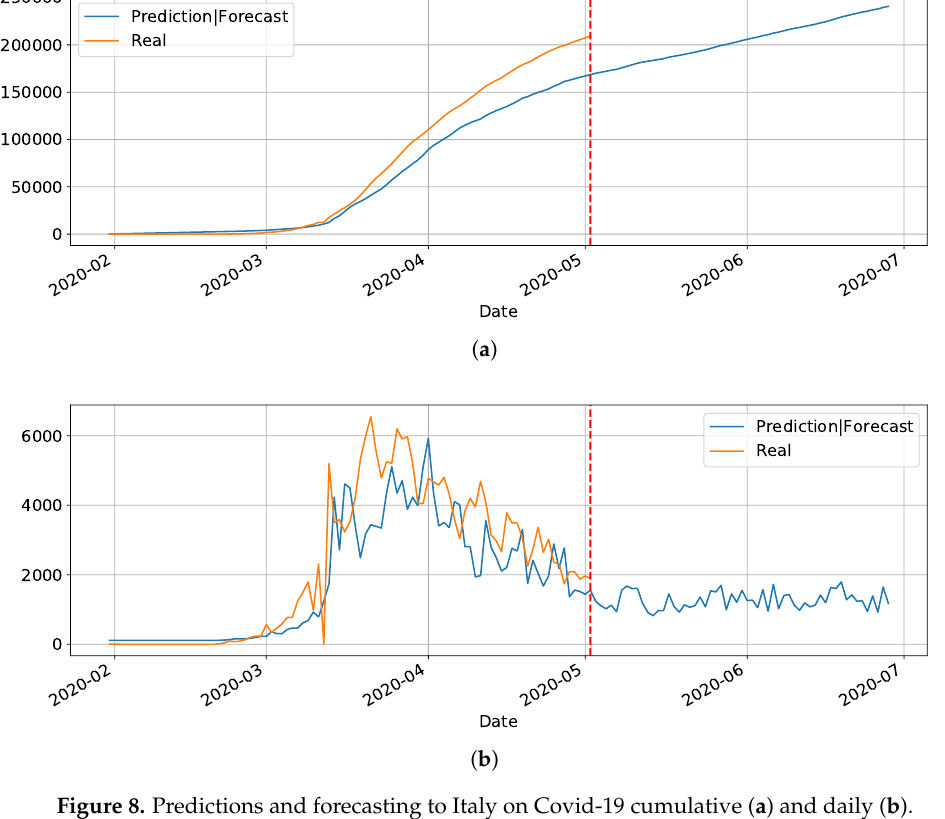
Figure 8. Predictions and forecasting to Italy on Covid-19 cumulative ( a ) and daily ( b ).